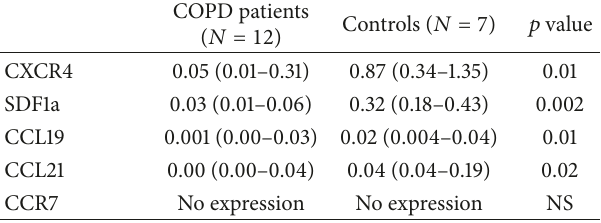
Table 5: Real-time RT-PCR results.